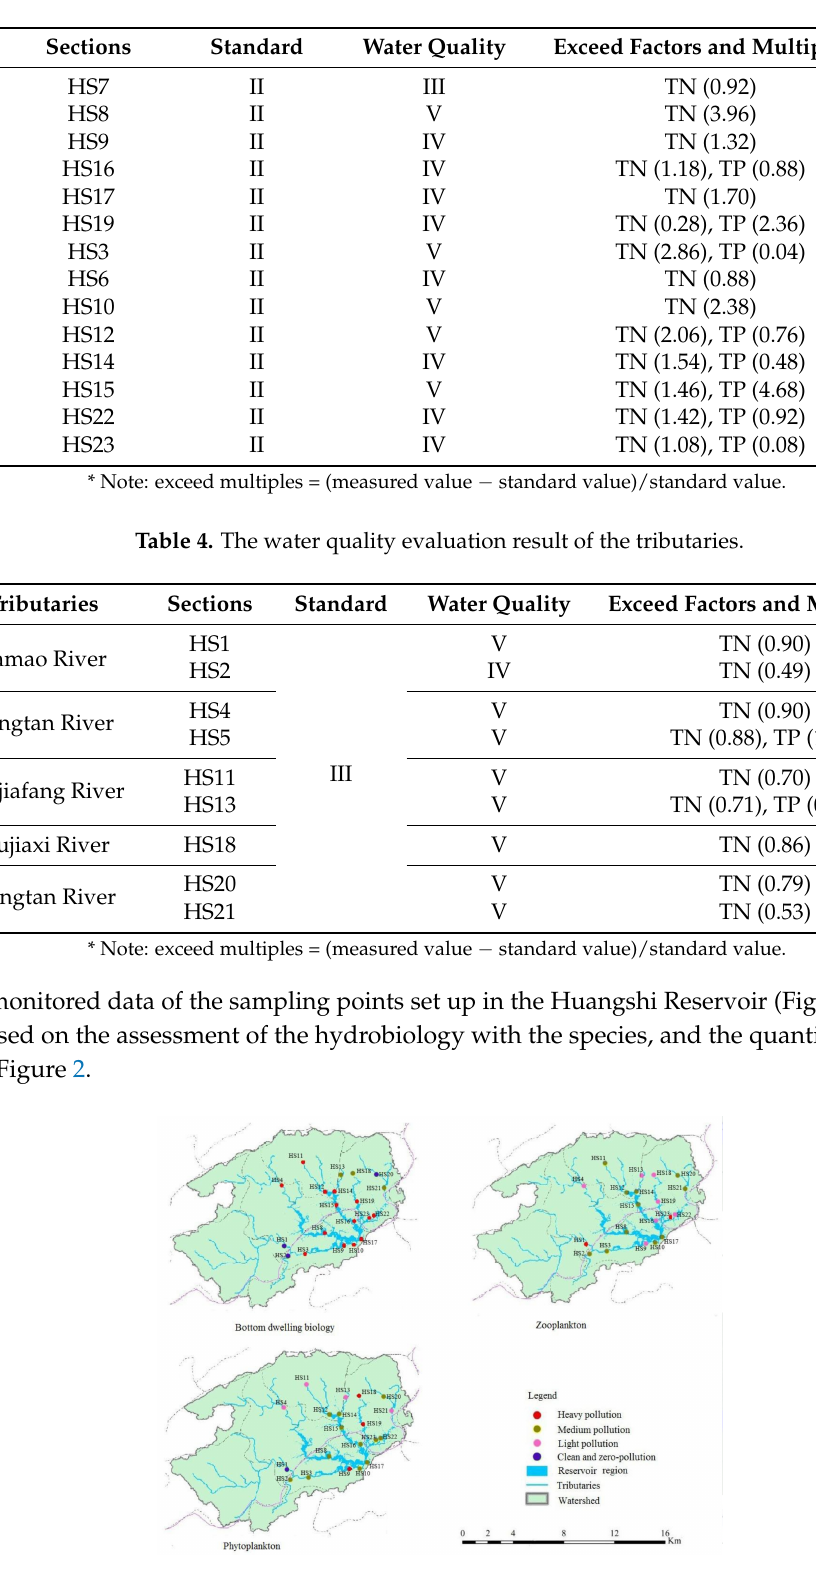
Figure 2. The assessment results of water